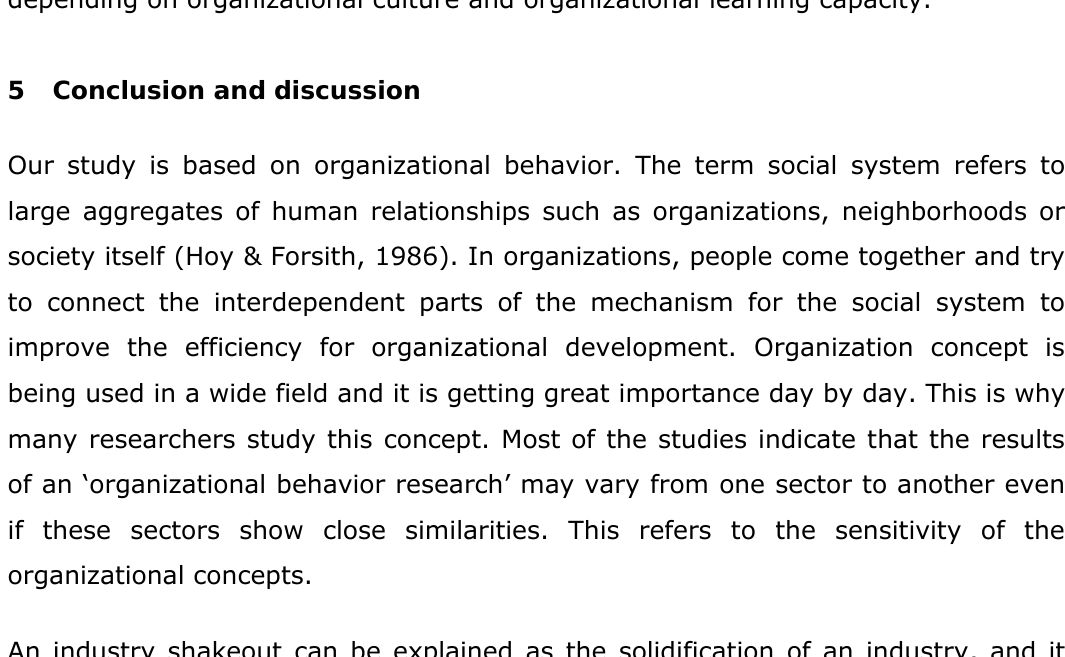
Equation 1. “Employee Satisfaction depending on organizational culture and organizational learning